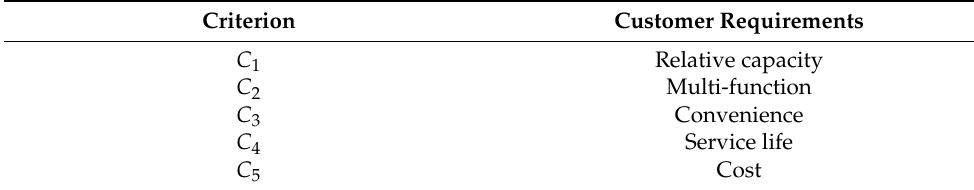
Table 1. Customer